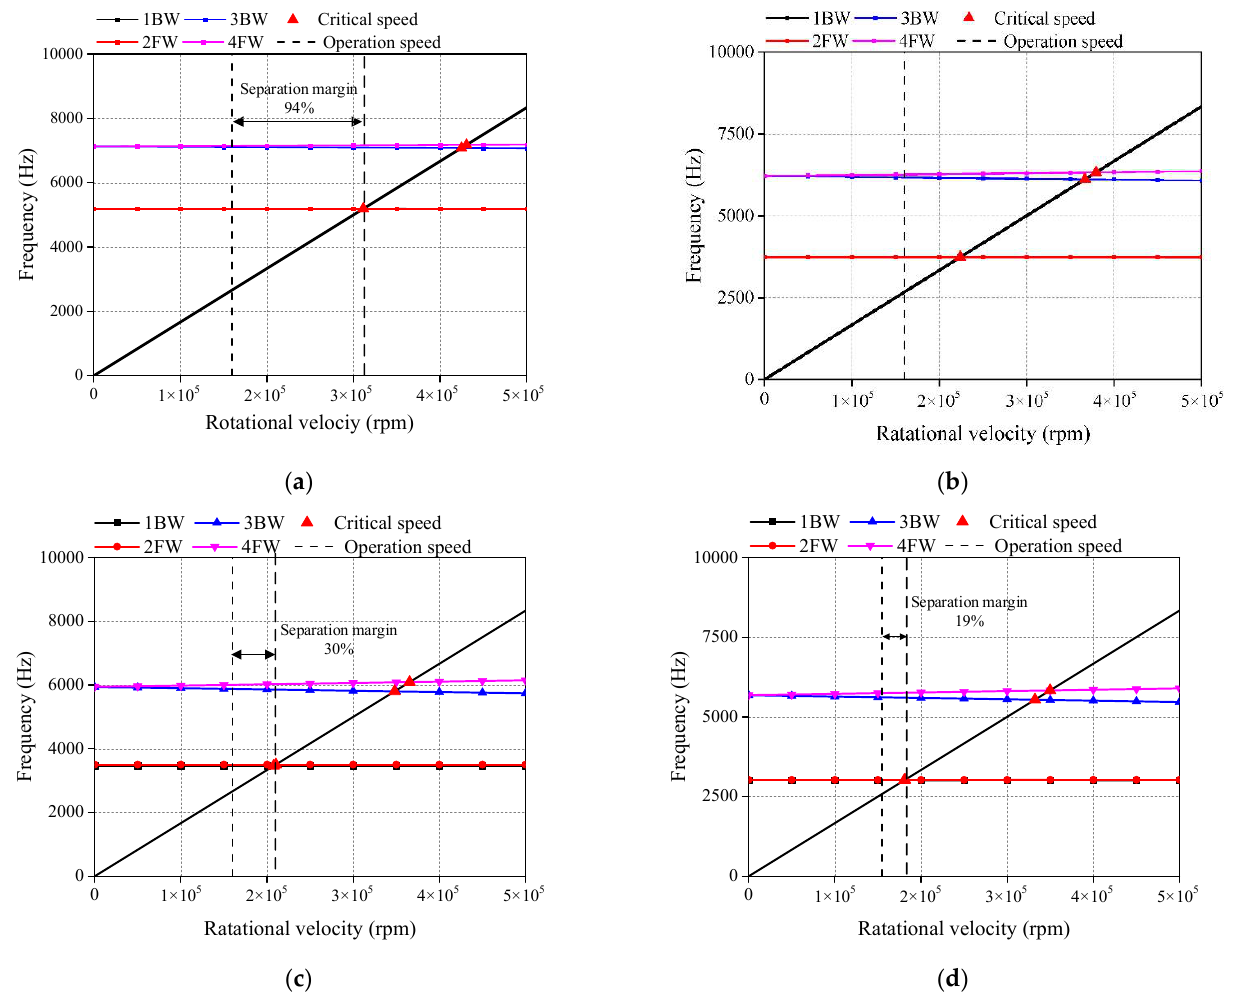
Figure 7. Campbell diagram of HSPMSMSs with different rotors. ( a ) M1; ( b ) M2; ( c ) M3; ( d ) M4.